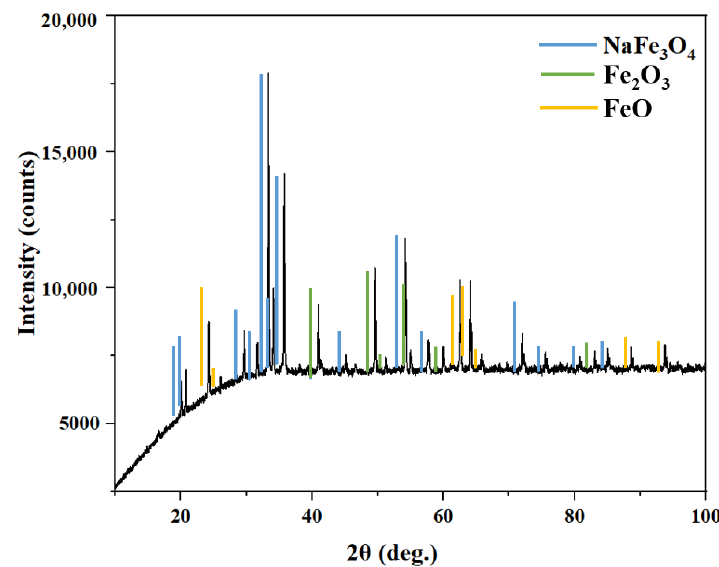
Figure 2. XRD pattern of the synthesized catalyst.